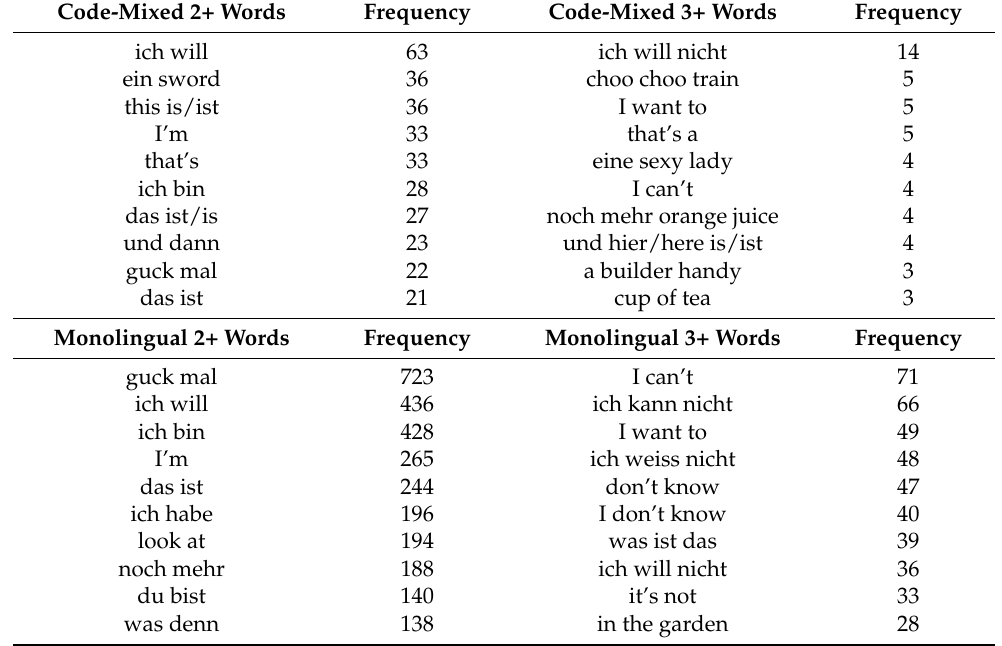
Table 2. The top 10 most frequent chunks with 2 or more (left) or 10 or more words (right) identified by the CBL algorithm in the child’s code-mixed (upper 10 rows) and the monolingual utterances (lower 10 rows).